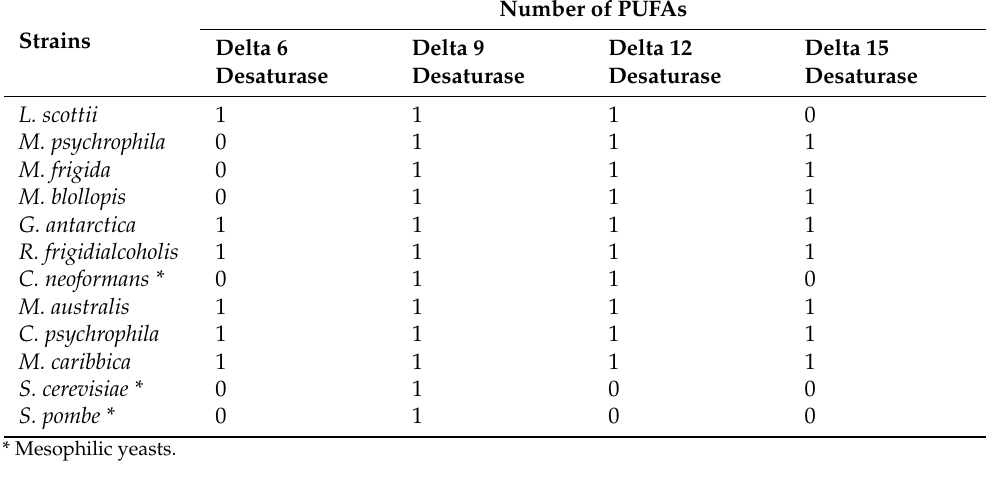
Table 2. FADs of different yeasts.